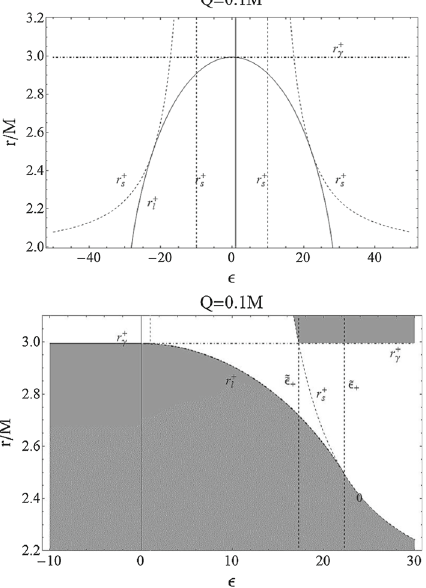
Fig. 3 Black hole case with Q = 0 . 1 M . T the radii r + s , r + plotted as functions of the test particle charge-to-mass ratio (cid:2) . Shaded regions are forbidden